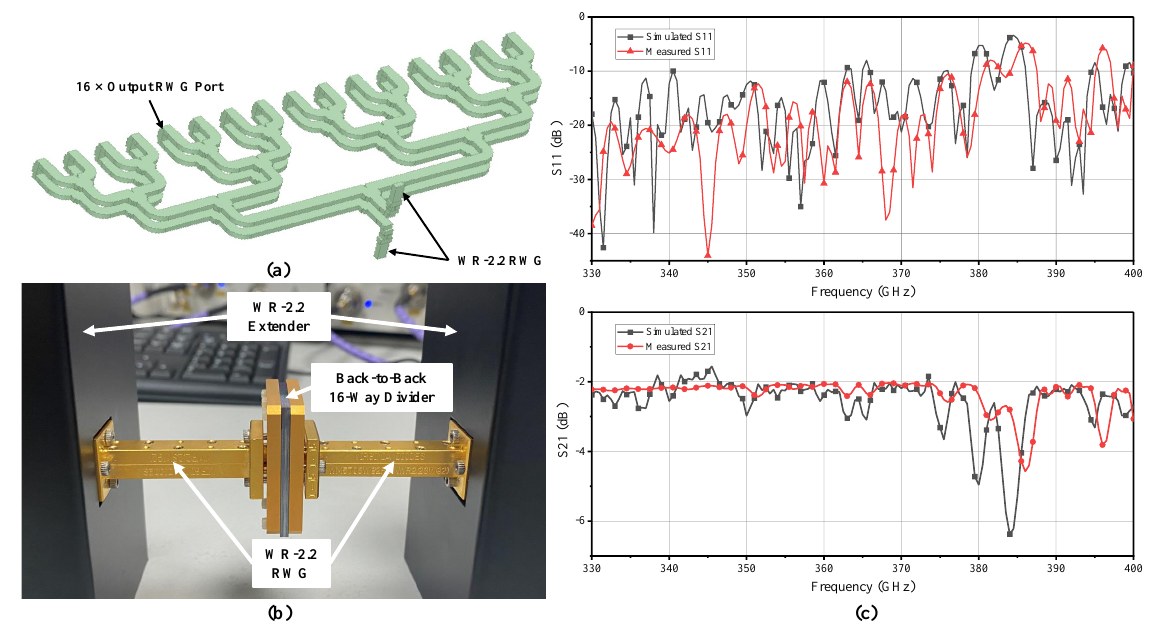
Figure 14. ( a ) The simulation model of the back-to-back 16-way power divider in HFSS. ( b ) The measurement setup of the back-to-back 16-way power divider. ( c ) The measured vs. simulated insertion loss and return loss for the back-to-back 16-way power divider.